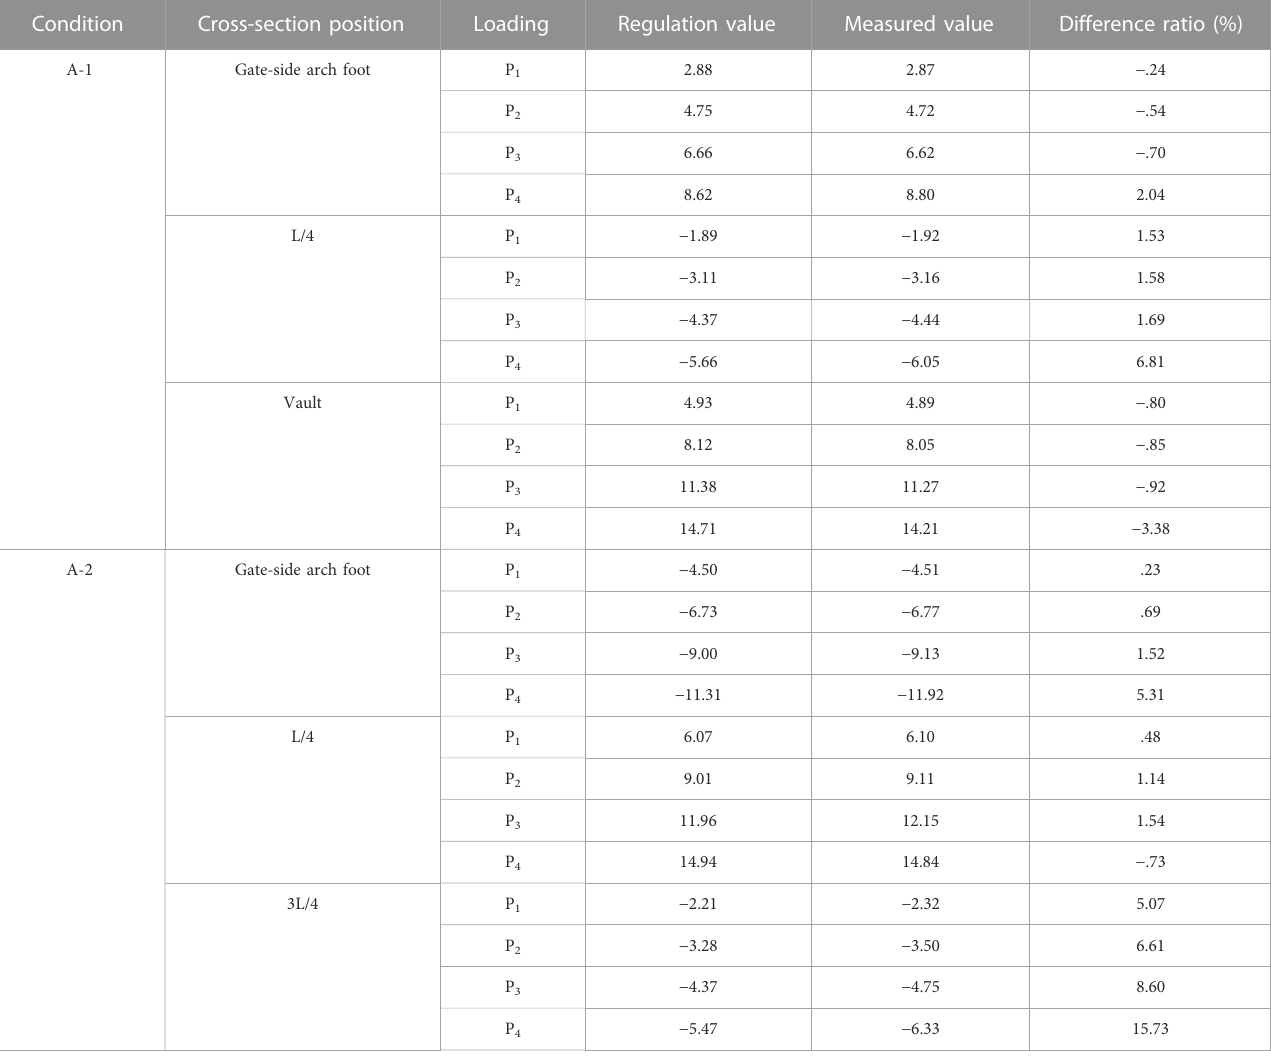
TABLE 12 Comparison of regulation values and measured values (unit: kN m). Condition Cross-section